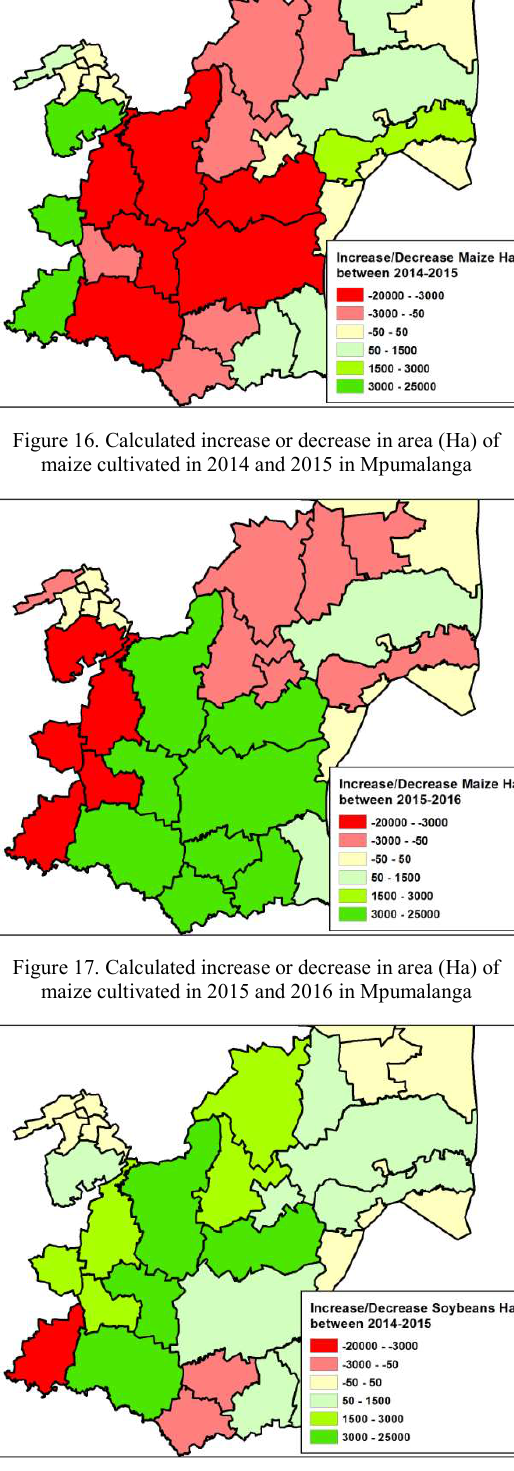
Figure 18. Calculated increase or decrease in area (Ha) of maize cultivated in 2014 and 2015 in Mpumalanga